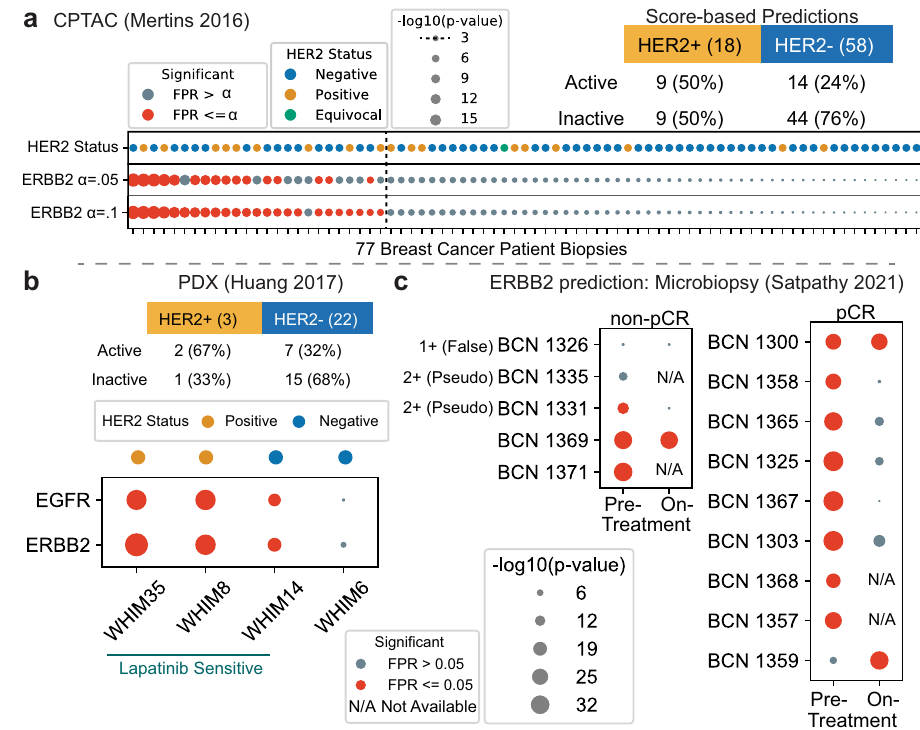
Fig. 6 | KSTAR applied to breast cancer biopsies in three studies. HER2 is used when referring to clinical diagnosis and ERBB2-activity for ERBB2/HER2 activity predictions. a KSTARpredictionsofERBB2-activityforthe77breastcancerpatients in the CPTAC dataset 5 and theirclinical IHC/FISHHER2-status isgiven(samples are ranked by ERBB2-activity prediction score). The table gives the total number of HER2-positive and HER-negative patients and the KSTAR predictions for ERBB2/ HER2activityforthebestofthreecutoffs(score-based)consideredfordesignation of ERBB2-active: FPR <=0.05, FPR <=0.1, and score >3. b Predictions of EGFR and ERBB2 activities for the patient-derived xenograft (PDX) models published in Huangetal. 8 subsetthatweretreatedwithlapatinib(EGFR/HER2targetedtherapy), where WHIM14 is a HER2-negative tumor that showed a surprising response